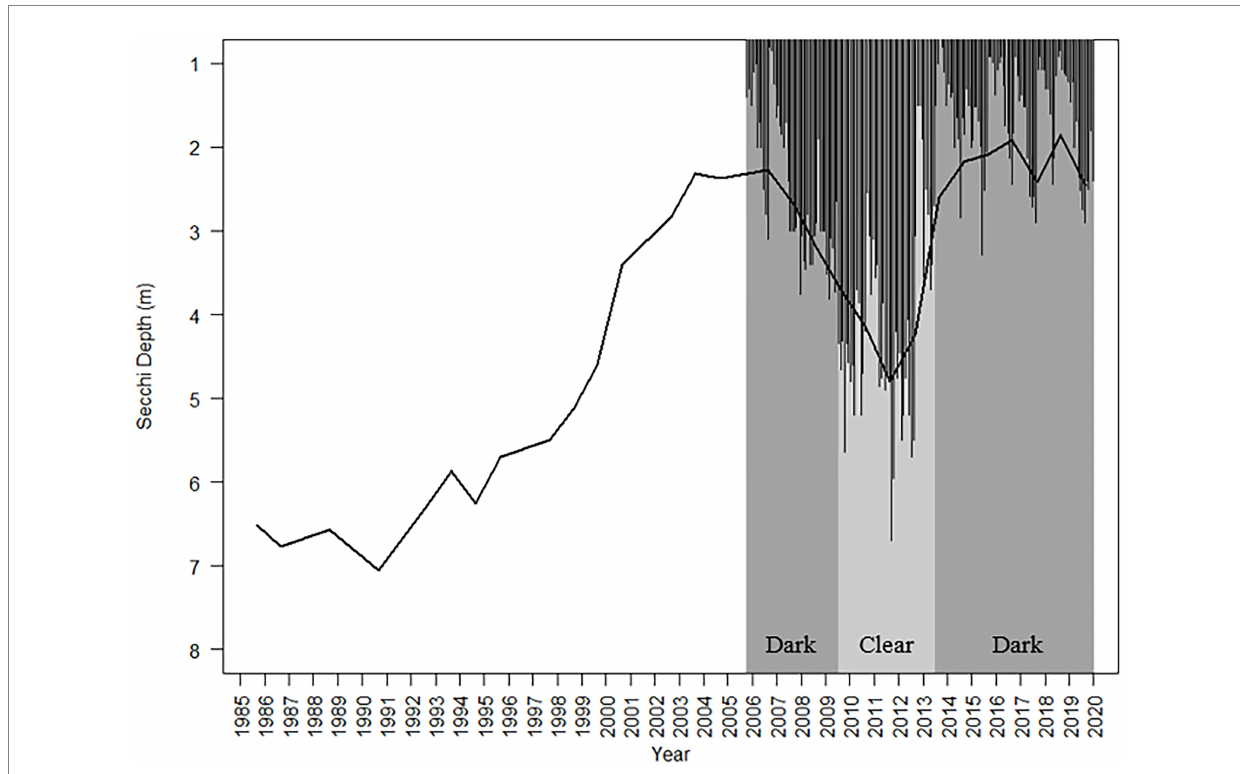
FIGURE 1 Average annual (1985–2019, line) and monthly (October 2005–December 2019, bars) Secchi depth measured during monthly phytoplankton sampling. The two diatom-based transparency phases are shown – dark (October 2005–July 2009 and August 2013–December 2019; indicated